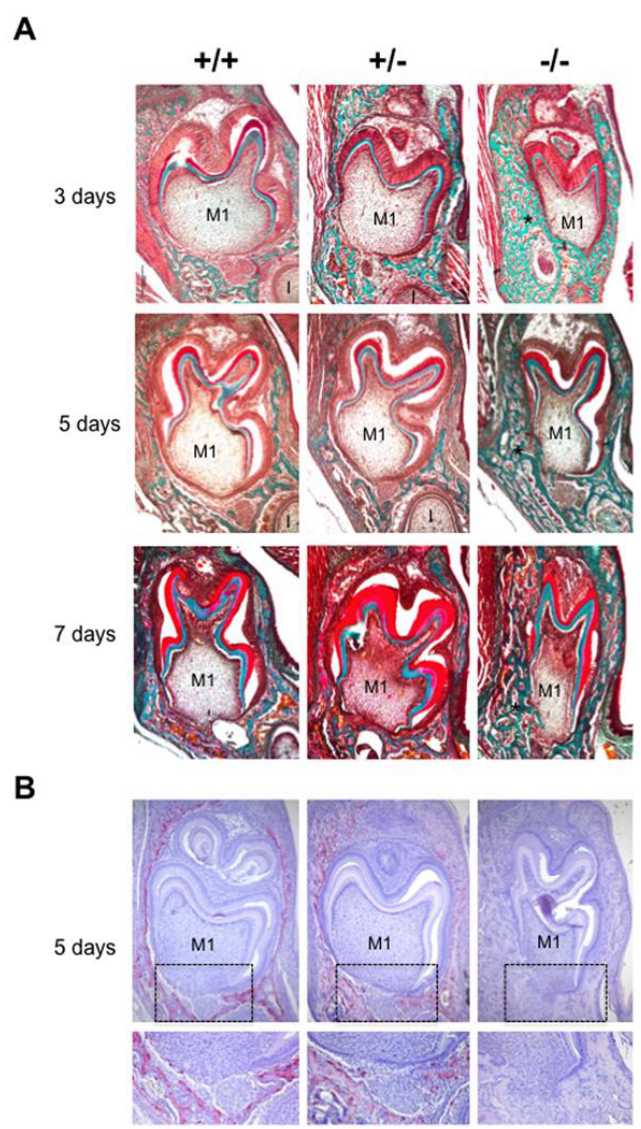
Figure 1. Histological comparative analyses of the dental phenotype related to the different Rankl genotypes. (A) Masson’s trichrome staining performed in 5µm thick frontal sections of the Rankl +/+ , Rankl +/- and Rankl -/- C57BL/6 mouse heads at the ages of 3, 5 and 7 days postnatal. At least five mice were analyzed for each genotype and at each age. An equivalent distribution of the bone matrix around the first molars (M1) was observed for the Rankl +/+ and Rankl +/- genotypes whatever the age considered. In contrast, for the Rankl -/- genotype, a grade increase in bone matrix deposition was observed with age (stars), so that the tissue boundary between the dental follicle and the apical papilla was interrupted, more specifically in the buccal region. Moreover, the Rankl -/- mouse molar presented over time progressive crown narrowing. I: incisor. Scale: 20X/100 µm. (B) TRAP histo-enzymology at